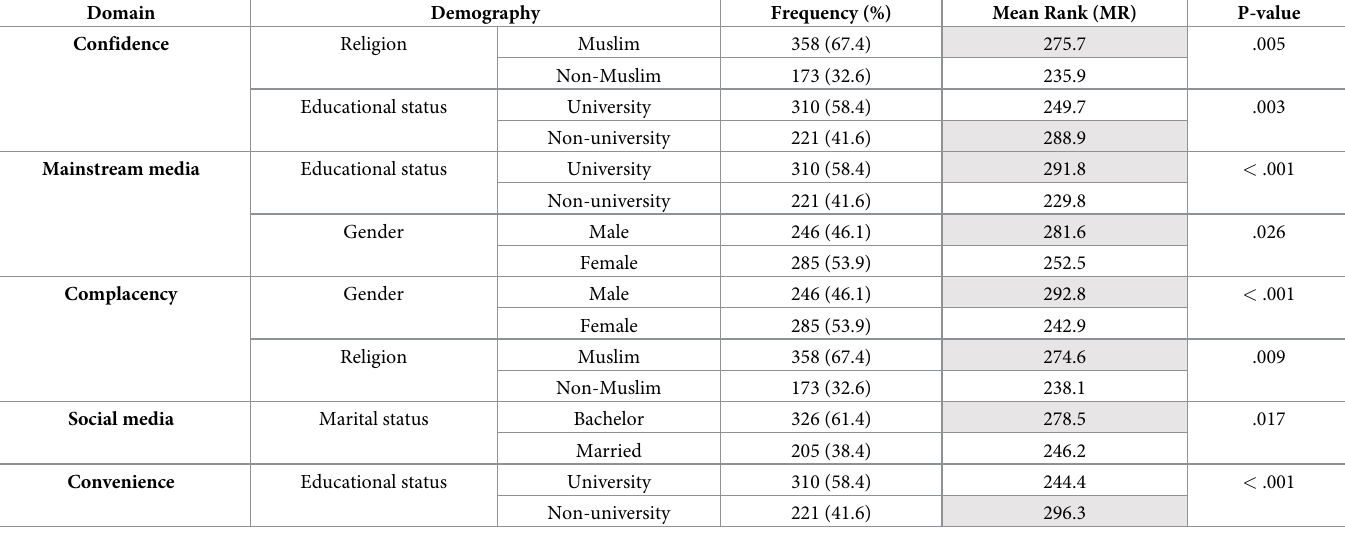
Table 8. The results of Mann-Whitney U test for Cluster